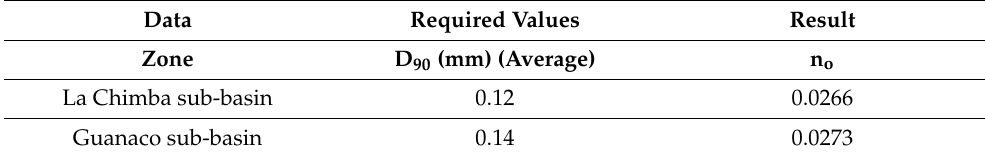
Figure 6. Triangular flood hydrograph for La Chimba basin. Represents the debris flow variation rates as a function of the rainfall event duration. The left figure indicates the La Chimba sub-basin (orange line) and the Guanaco sub-basin (purple line) unit hydrograph. The right figure indicates the unit hydrograph of the La Chimba basin mouth. Table 8. Effective diameters for the calculation of n o , which is the Manning coefficient index.